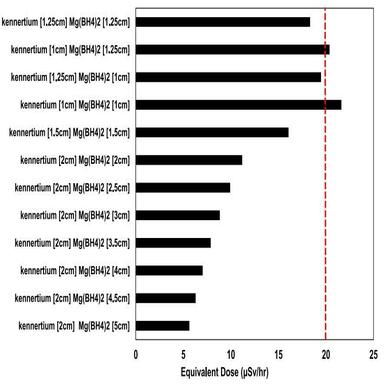
Total equivalent dose values for different combination of Kennertium and Mg(BH4)2.